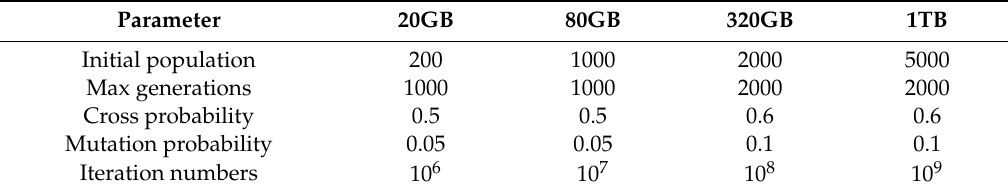
Table 1. Parameter settings of the corresponding genetic algorithm.